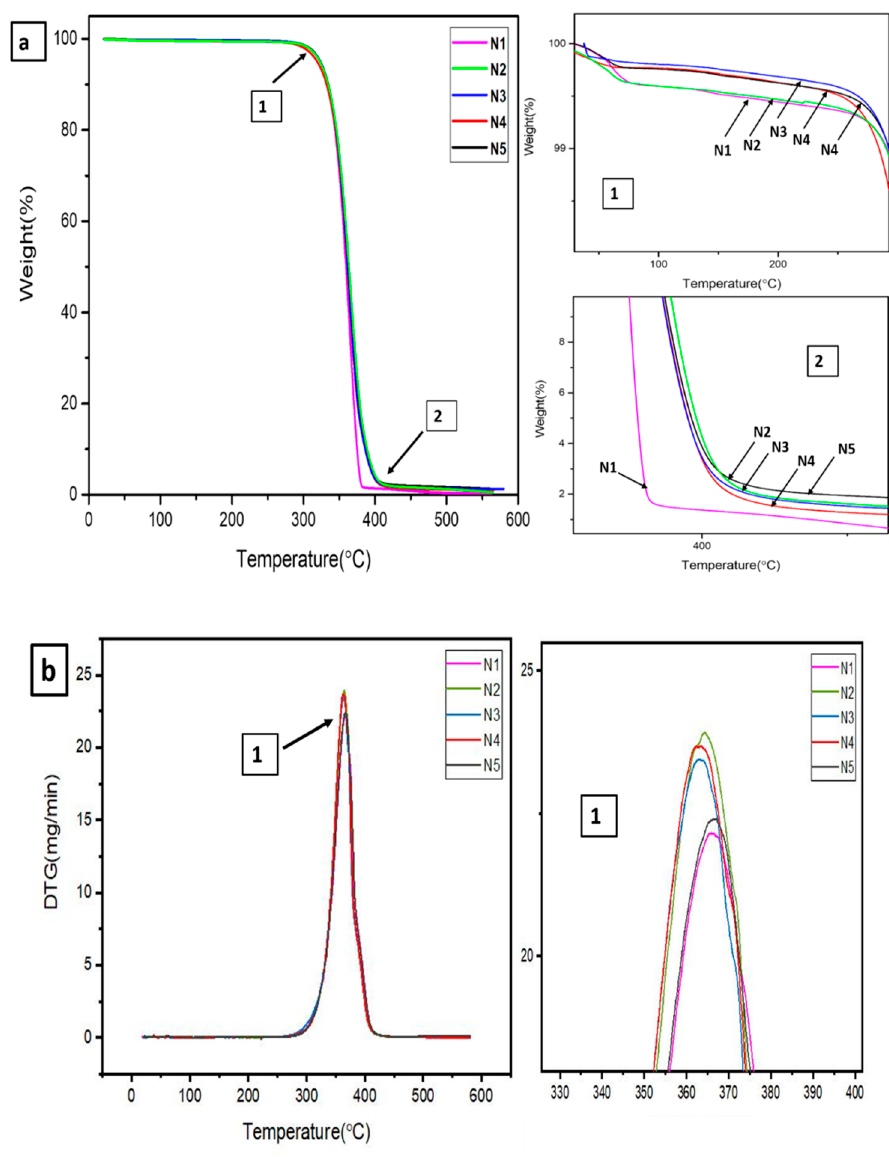
Figure 2. ( a ) TGA and ( b ) DTG of PLA/PBS, PLA/PBS/CNC composites.